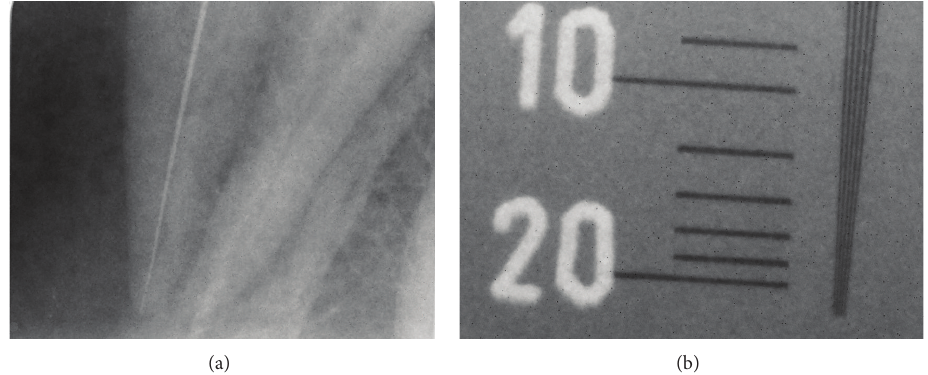
Figure 5: Group 1 LDXI static: (a) endodontic file number 10 at working length and (b) 18 lp/mm.